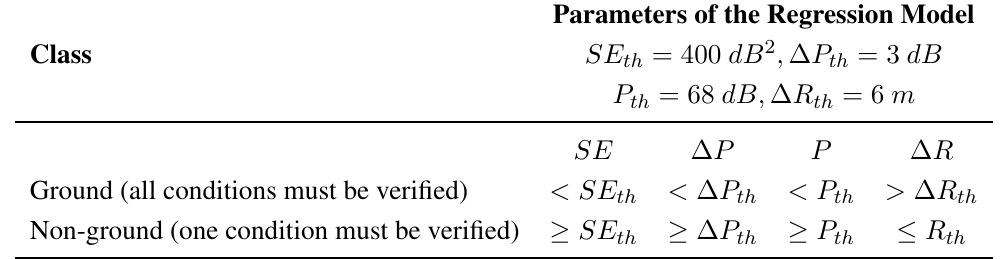
Table 1. Classification rules of the RCGD algorithm. Refer to Section 4.2 for more details on the